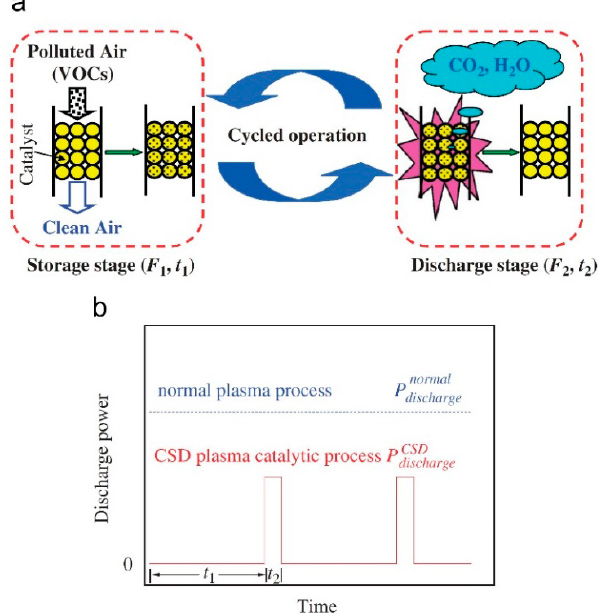
Figure 2. ( a ) Conceptual diagram of sequential treatment, ( b ) difference in discharge power between cycled storage-discharge (CSD) and a continuous plasma catalytic flow process. Reprinted from Ref. [39], with permission from